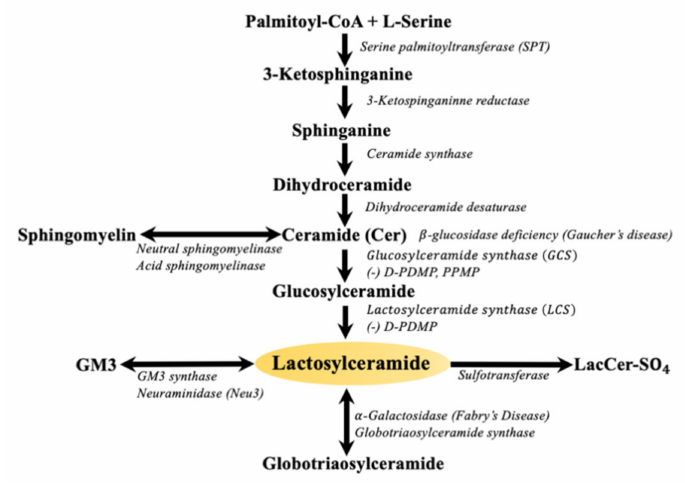
Figure 1. Biochemical pathways of lactosylceramide